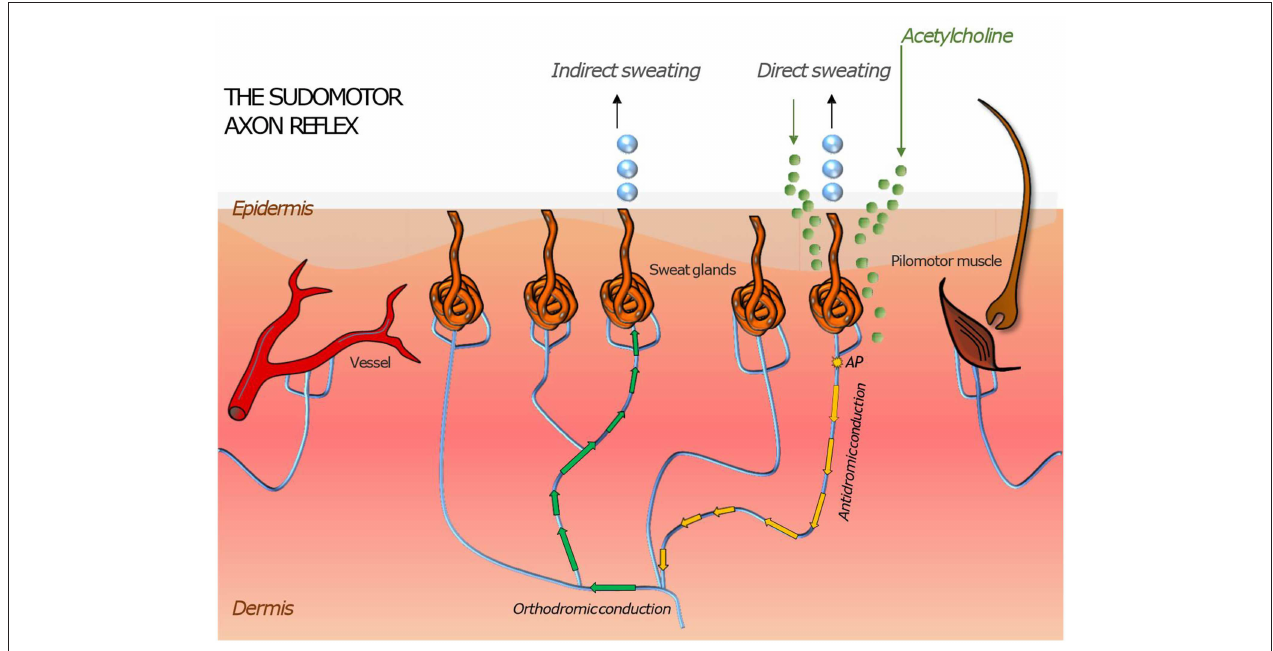
FIGURE 2 | Illustration of skin organs innervated by the autonomic nervous system with an axon reflex mediated in sudomotor nerve fibers by iontophoretic application of acetylcholine to the skin. Following a direct sweat response in the area of acetylcholine application, an action potential travels antidromically and then orthodromically to a neighboring population of sweat glands where it evokes “indirect” sweating in a skin region adjacent to the region of iontophoresis. Similar responses can be induced in pilomotor and vasomotor fibers. Their magnitude is a surrogate measure of functional integrity of the autonomic nerve fiber mediating the axon